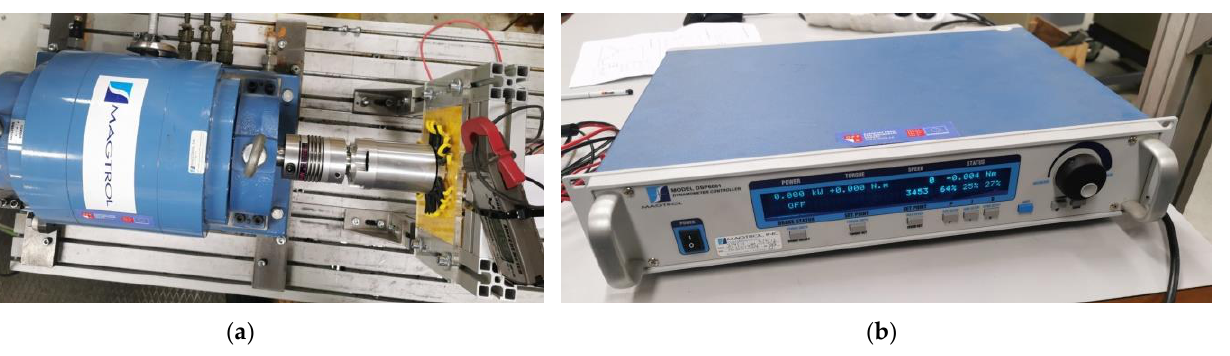
Figure 7. Modification example of the inner winding configuration using 3 FETs.